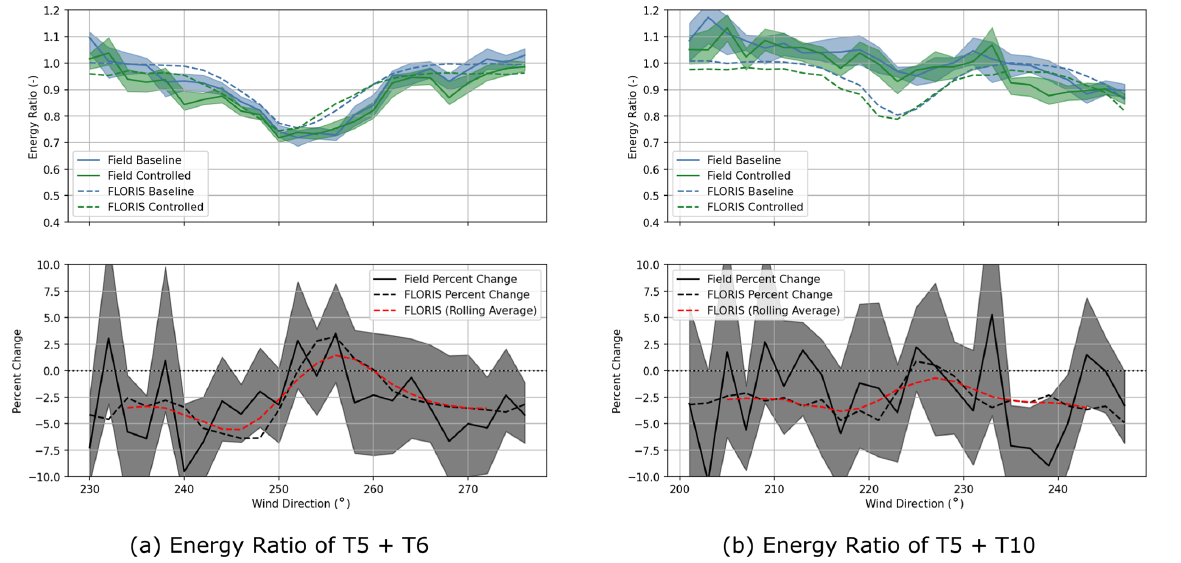
Figure 9. Energy ratio and percent change for combined upstream and downstream wind turbine